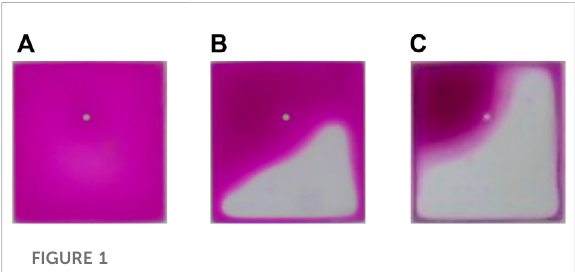
FIGURE 1 The state of pixels under different applied electric fi elds. (A) When no electric fi eld is applied, the pixel shows the color of oil fi lm. (B,C) are “ on ” states of a pixel when an electric fi eld is applied. (C) Whenamaximumvoltageisapplied,thepixel approaches the most transparent state and the color of the white substrate is